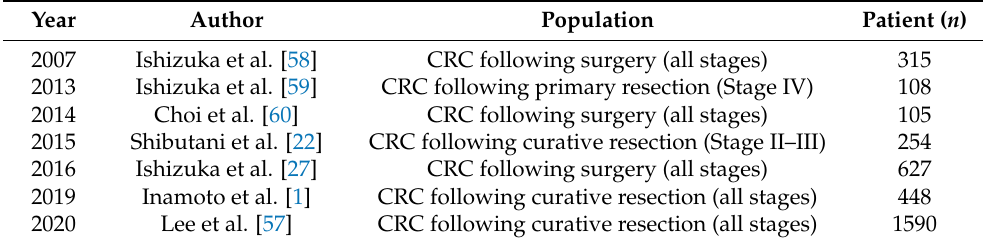
CRC: colorectal cancer, CRLM: colorectal liver metastasis.